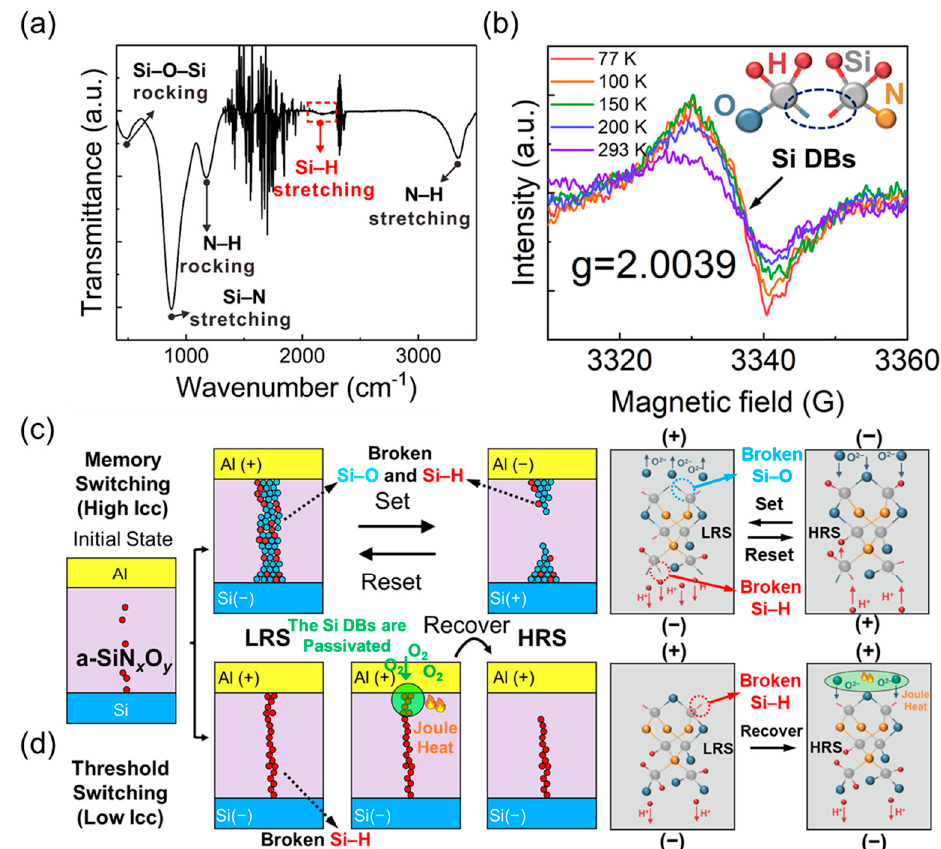
Figure 3. ( a ) FTIR spectrum of the as-deposited a-SiN x O y :H layer; ( b ) Temperature-dependent ESR spectra of the a-SiN x O y :H device; Schematic diagram of ( c ) memory switching and ( d ) threshold switching mechanism in Al/a–SiN x O y :H/P + –Si device.